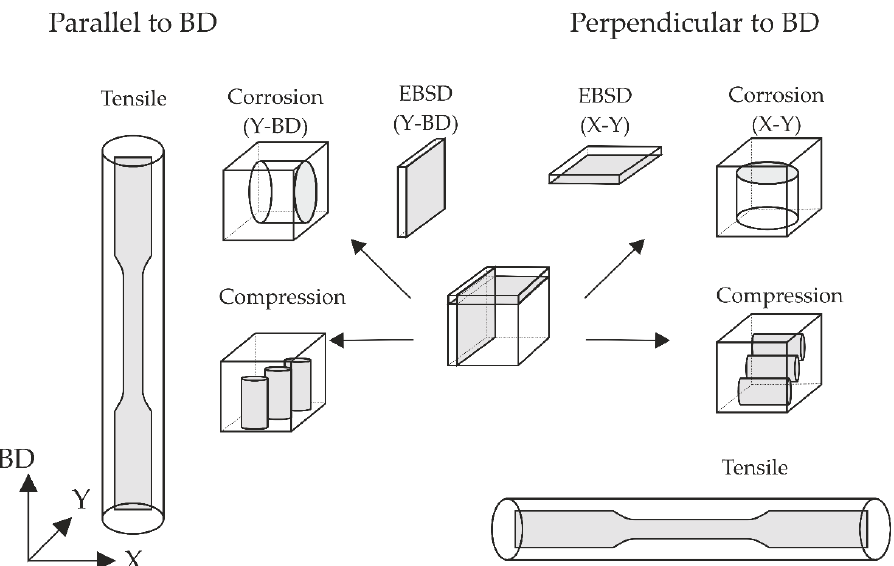
Figure 1. Coordinate system and test samples machined out of cubes and cylinder specimens arranged parallel and perpendicular to the build direction (BD) for quasi-static tensile and compression tests, electron backscatter diffraction (EBSD) analysis and potentiodynamic polarization measurements.